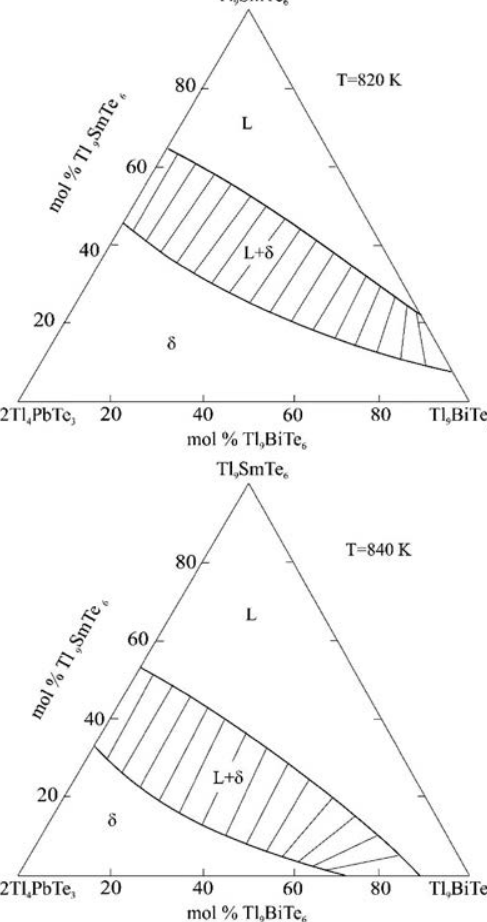
Fig. 5. Isothermal sections at 820 and 840 K in the Tl 4 PbTe 3 -Tl 9 S-